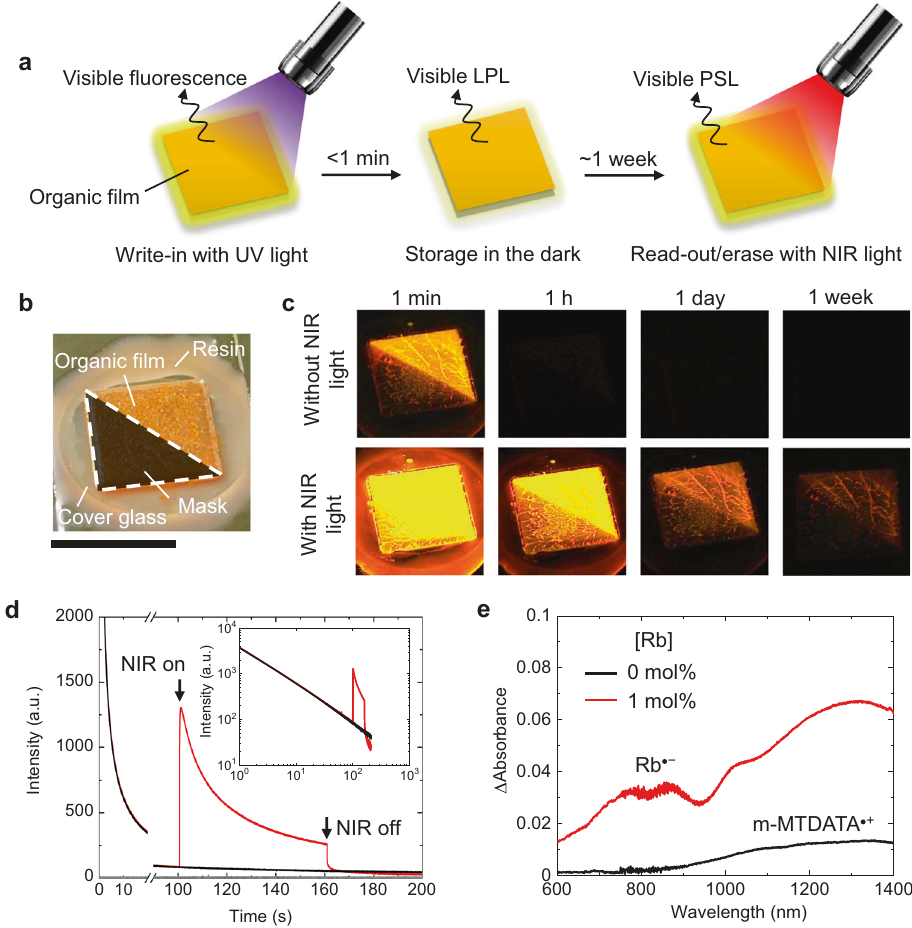
Fig. 2 Organic PSL from the m-MTDATA/PPT/Rb blend fi lms. a Write-in and read-out processes. b Photograph of the m-MTDATA/PPT/Rb fi lm. A part of the sample was masked during UV light irradiation. The scale bar is 10 mm. c Photographs of the samples without and with 800-nm light irradiation after stopping 365-nm light irradiation. d Emission decay pro fi les obtained for the m-MTDATA/PPT/Rb fi lm with and without 800-nm light irradiation (red and black lines, respectively). The decay pro fi le observed without UV pre-irradiation is also shown (gray line). The emission intensity was integrated over the wavelength range of 500 − 700 nm (Supplementary Figure 5d). The inset shows the logarithmic plots of the decay pro fi les. e Differential absorption spectra obtained for the m-MTDATA/PPT/Rb (0, 1 mol%) fi lms before and after 365-nm light